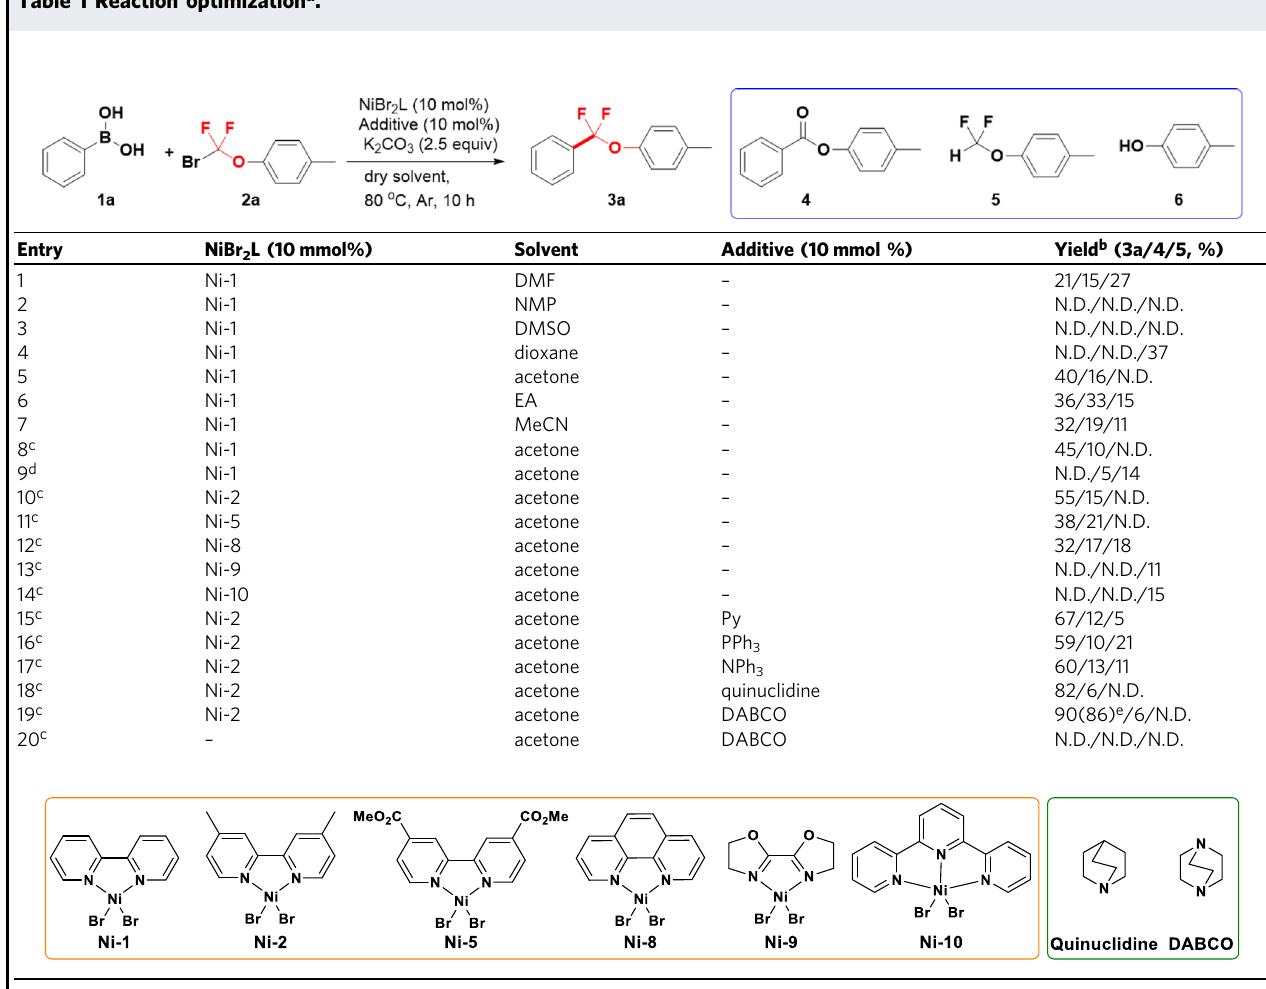
Table 1 Reaction optimization a